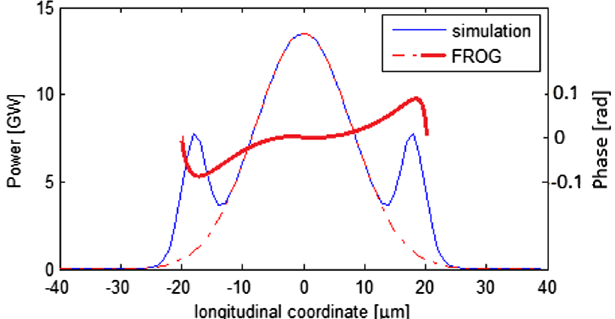
FIG. 6. Seed laser longitudinal profile used as the initial condition in the Fig. 7 simulations of the measurements (blue) and FROG measurement of seed